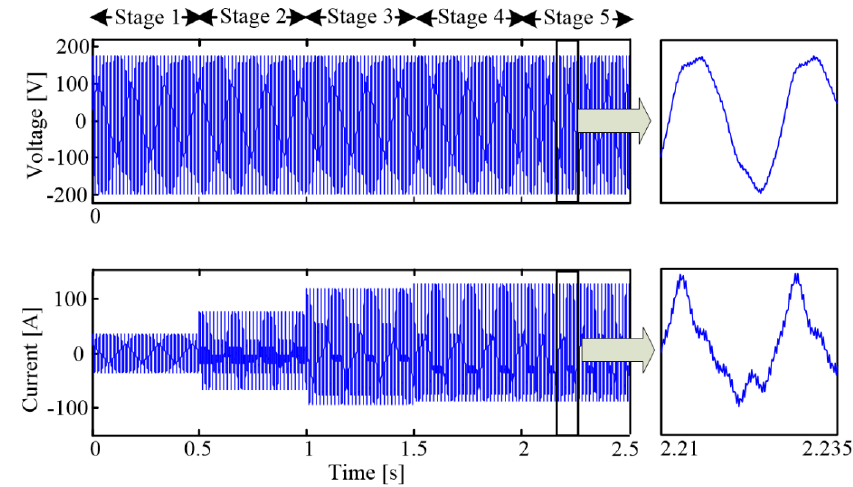
Figure 4. Synthetic signals for voltage and current.